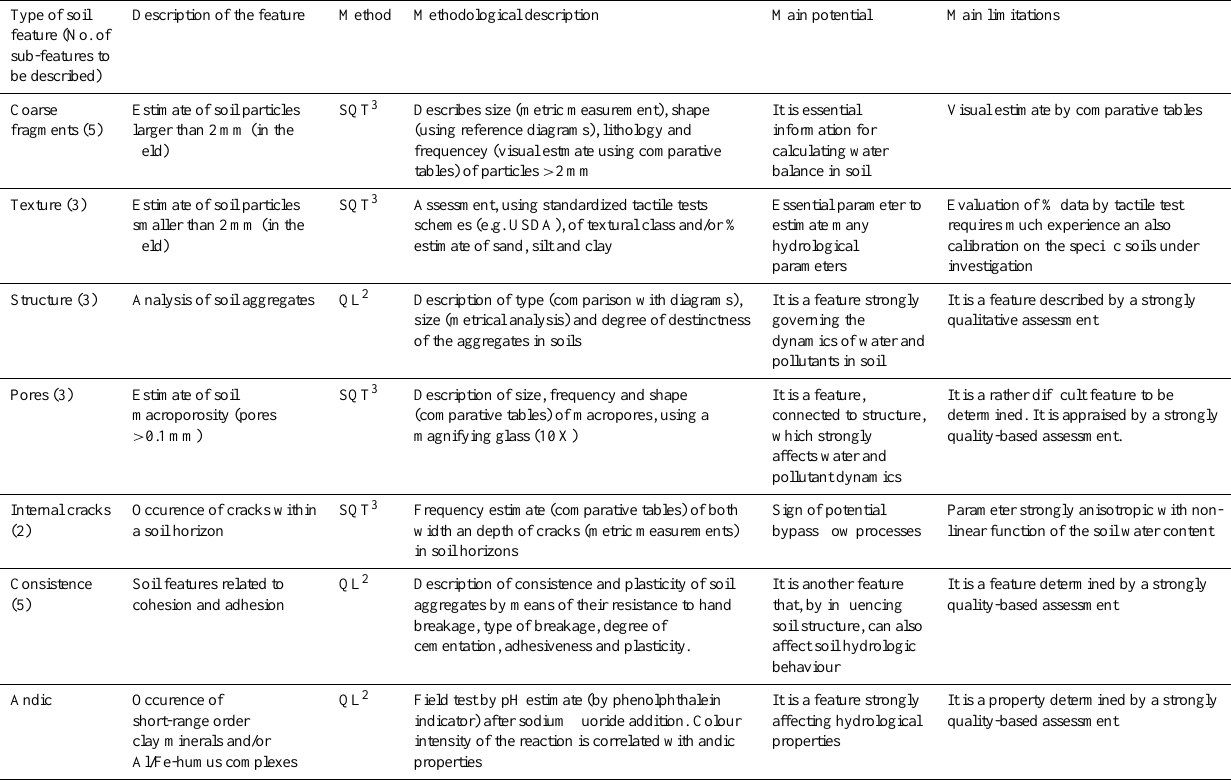
Table 3b. Types of data of great (and direct) hydrological interest contained in soil map